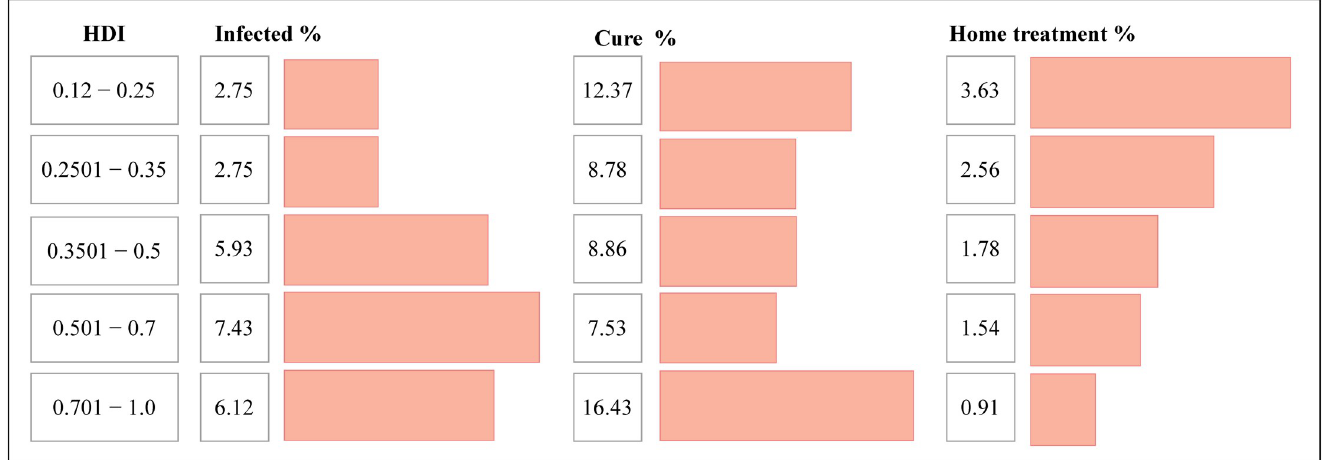
Fig 8. Social analysis of the pandemic spread to the city of Fortaleza. Results of the social analysis of the spread of the virus under the context of HDI in the neighborhoods of the city of Fortaleza. As we can see, we found that the higher the HDI, the higher the percentage of infected people in the region, as well as the higher recovery, which we believe is directly associated with the greater number of patients with access to quality private hospital treatment. On the other hand, in regions with the lowest HDI rates, we observed the highest percentage of treatments performed independently, which can be explained by the lack of access to public service.